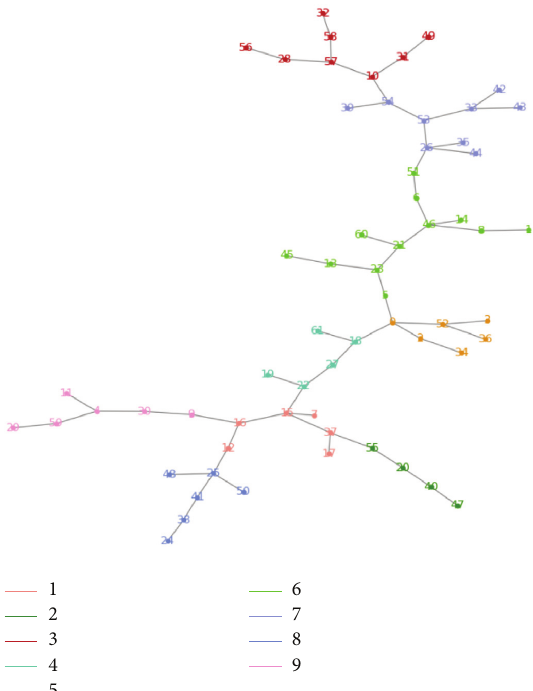
Figure 8: The community of energy stock price jump from April 2017 to October 2017.